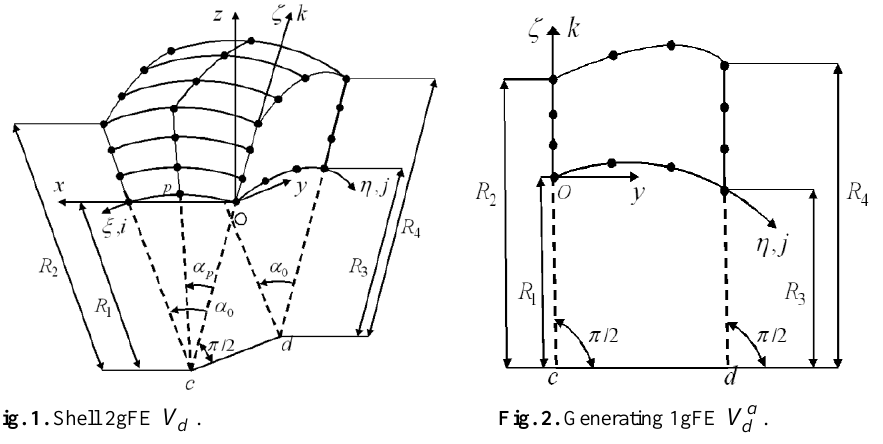
Fig. 1. Shell 2gFE